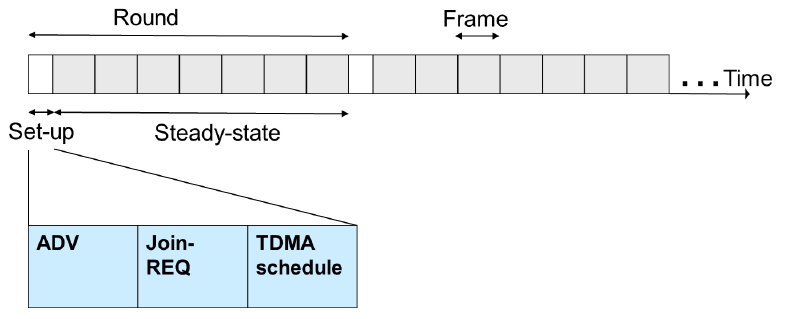
Figure 4. LEACH protocol